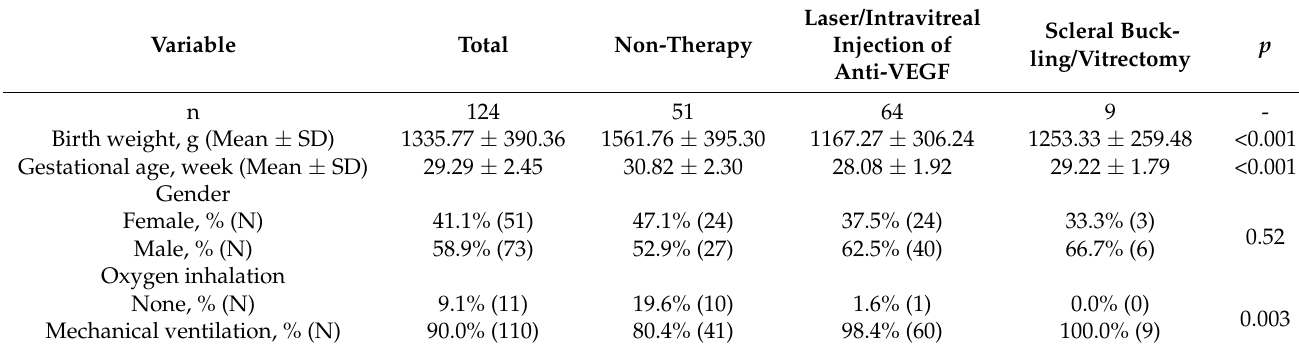
Table 1. Demographic characteristics and treatments of all ROP infants.